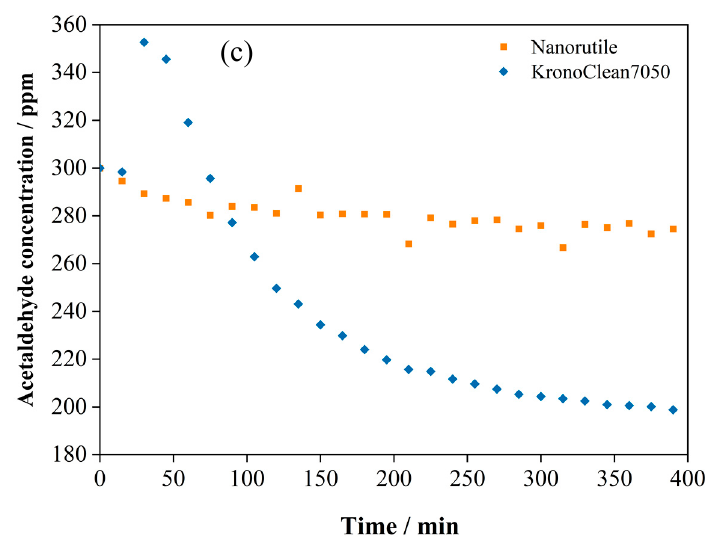
Figure 5. Photocatalytic decomposition of acetaldehyde on the titania samples under irradiation of a fluorescent lamp: heat-treated in Ar ( a ), hydrogen ( b ), and commercial ( c ).